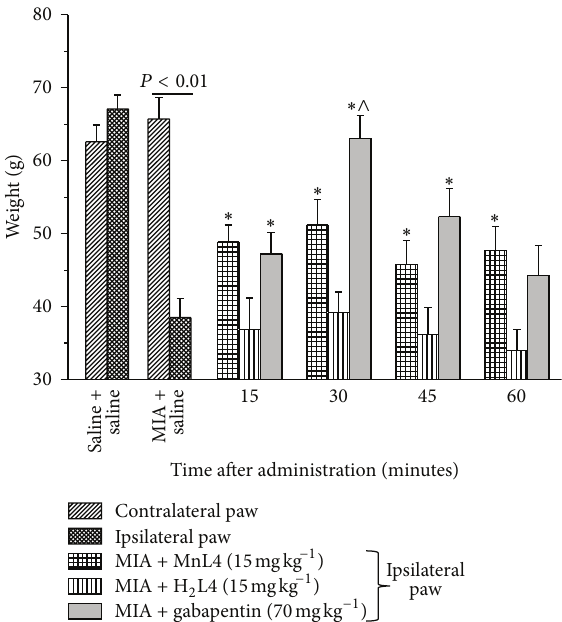
Figure 3: Effect of MnL 4, H 2 L 4 , and gabapentin (acutely adminis- tered) on monoiodoacetate- (MIA-) induced unilateral osteoarthri- tis. MIA (2 mg /25 𝜇 L ) was injected in the left posterior tibiotarsal articulation 14 days before pain evaluation by the paw pressure test. Molecules or saline was administered i.p. at time 0 and measures were performed at time 15, 30, 45, and 60min. Values are the mean ± s.e.m. of 6 animals. ∗ 𝑃 < 0.05 versus the ipsilateral paw of MIA + saline group, ∧ 𝑃 < 0.05 versus MIA + MnL 4 at the same